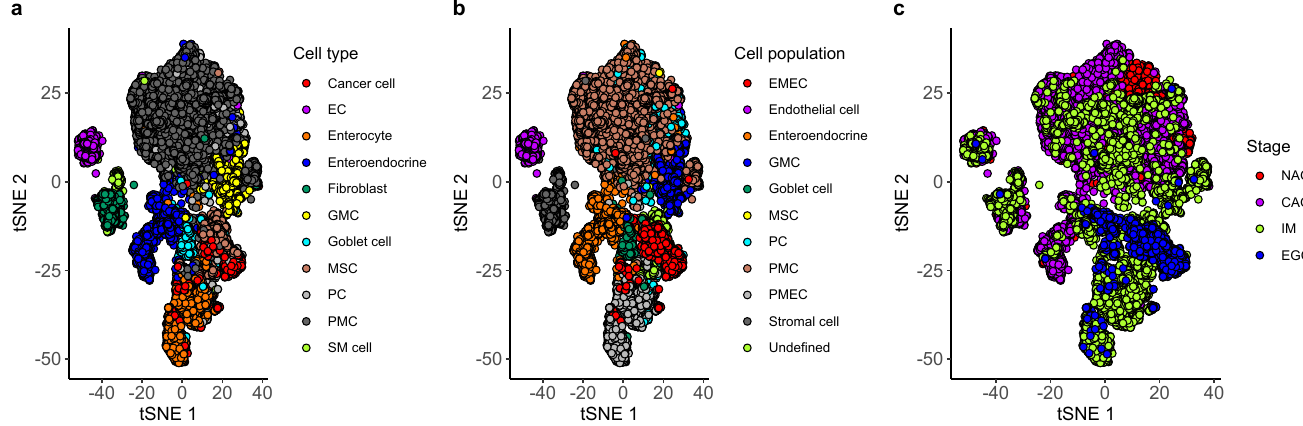
Figure 2. The t-SNE plot of whole transcriptomes of 24,874 cells from gastric antral mucosa biopsies. ( a ) The 11 cell types are denoted by distinct colors. ( b ) The 10 identified cell populations are denoted by distinct colors. ( c ) The 4 stages are denoted by distinct